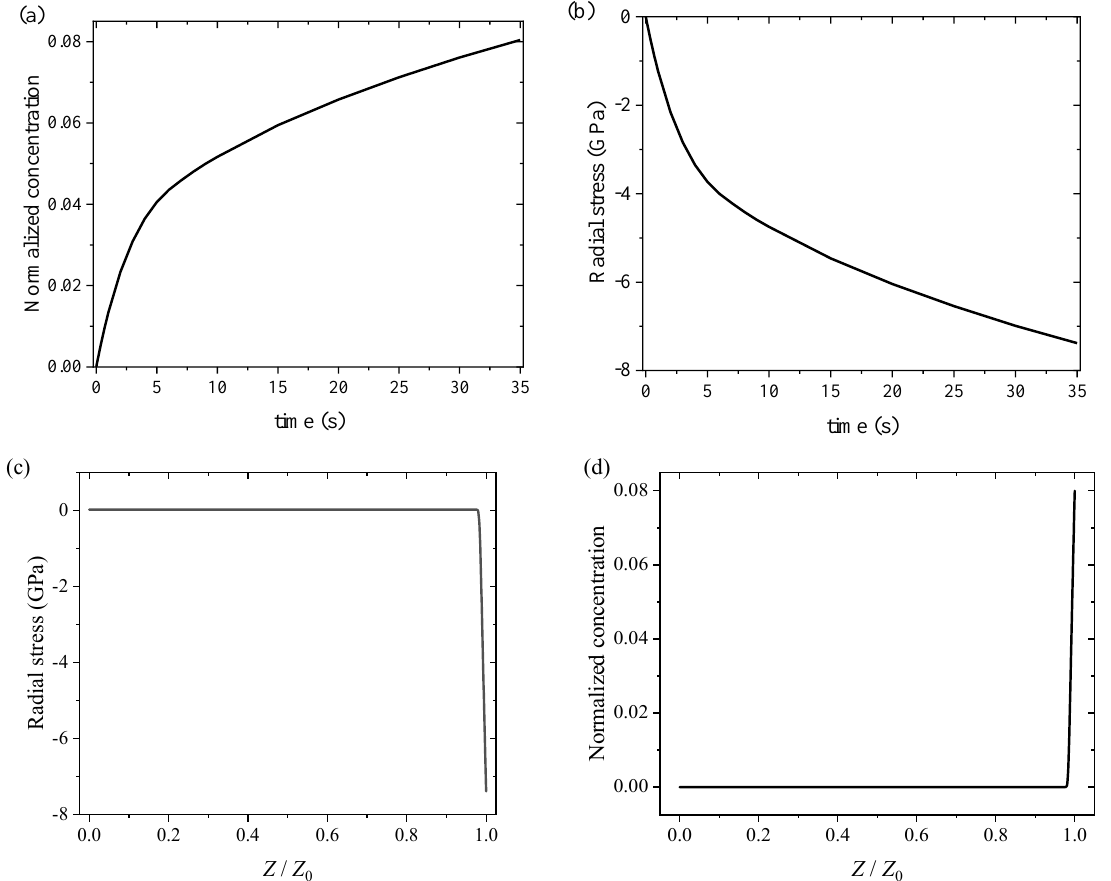
Figure 6. Temporal evolutions of ( a ) the normalized concentration and ( b ) the radial stress at the center of the top surface of the Si thin film at stage 0; spatial distribution of ( c ) the radial stress and ( d ) the normalized concentration along the film thickness at the end of stage 0. Figure 7 depicts spatial variations in normalized concentration and radial stress along the axisymmetric axis under different total C-rates at the end of stage 0. A large amount of Li accumulates near the top surface of the thin film (Figure 7a). The larger the C-rate, the sharper the drop in Li-concentration and the narrower the diffusion zone, as expected. According to Figure 7b, the larger the C-rate, the narrower the compressive- stress zone at the surface. Note that the un-lithiated Si experiences tensile stress, whose magnitude increases with the decrease in the C-rate at the end of stage 0. Moreover, the magnitude of the radial stress at the surface of the a-Si film ( Z / Z 0 = 1) is about 7.4 GPa at the end of stage 0, independent of the total C-rate used for the lithiation.